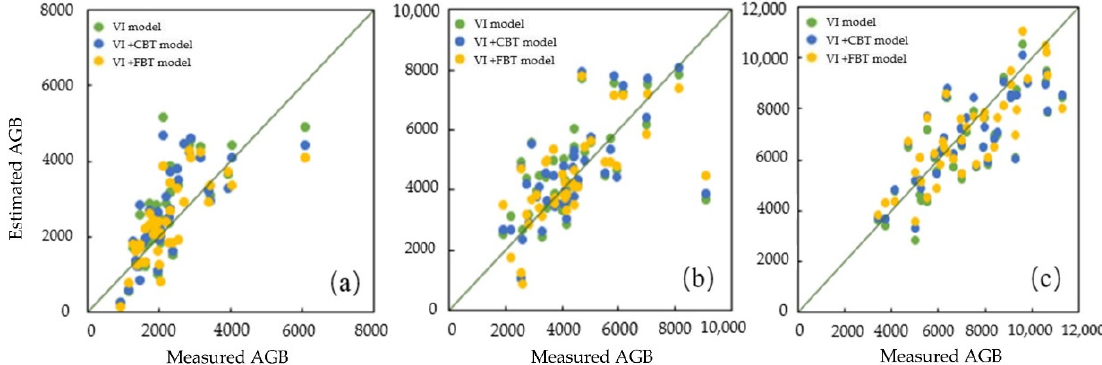
Figure 8. Scatter plot of AGB estimation with three models in each growth stage. ( a ) Tillering stage, ( b ) jointing stage, ( c ) booting stage. Green: vegetation index model (VI model); blue: vegetation index combined with corresponding-band textures model (VI+CBT model); yellow: vegetation index combined with full-band textures model (VI+FBT model).